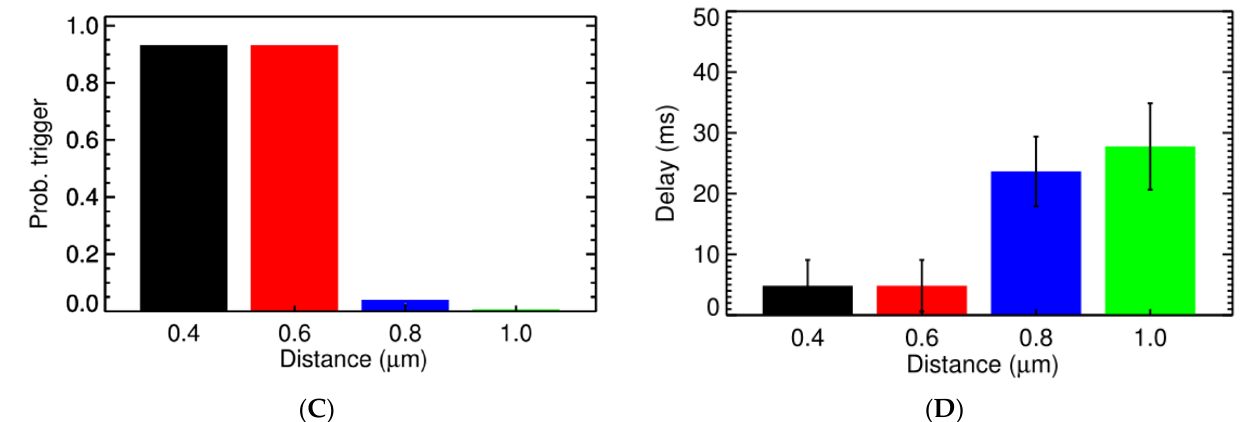
Figure 6. The probability of one CRU triggering the neighboring one at different distances and the delay. ( A ) The probability of triggering a spark at the second CRU at different distances from an activated CRU under the high overload condition ([Ca 2+ ] = 0.156 µM, and [Ca 2+ ] nsr = 1.70 mM). ( B ) The delay in triggering the second CRU under that high overload condition. ( C ) The probability of triggering a spark at the second CRU at different distances from an activated CRU under the low overload condition ([Ca 2+ ] myo = 0.156 µM, and [Ca 2+ ] nsr = 1.30 mM). ( D ) The delay in triggering the second CRU under that low overload condition.